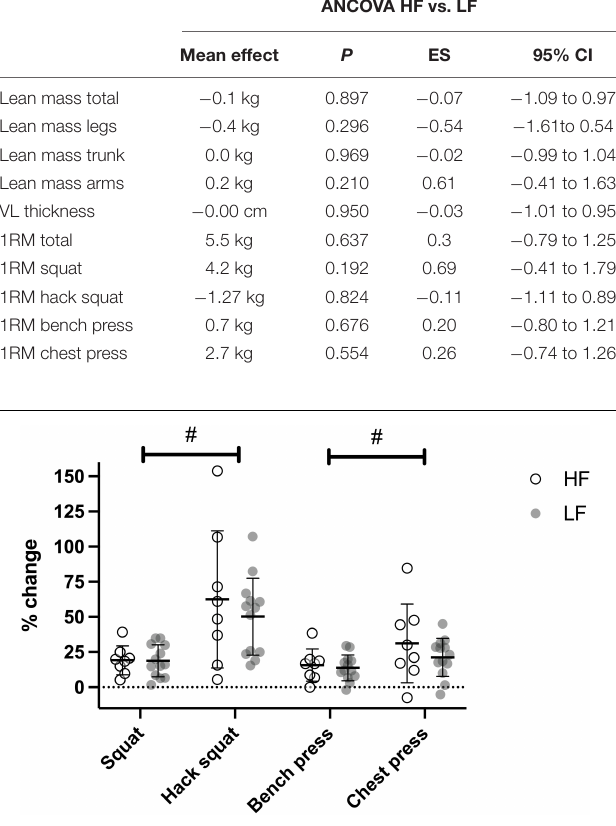
FIGURE 2 | Percent changes in one repetition maximum for squat, hack squat, bench press, and chest press. Horizontal lines are averages with error bars representing SD. # Difference between simple and complex exercises, p <